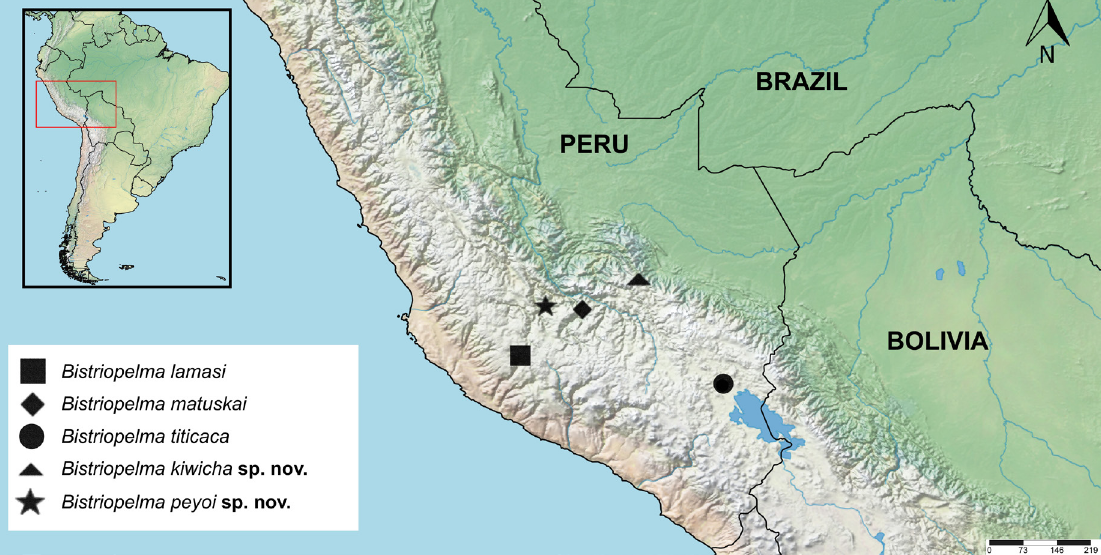
Fig. 14. Distribution map of the known species of Bistriopelma